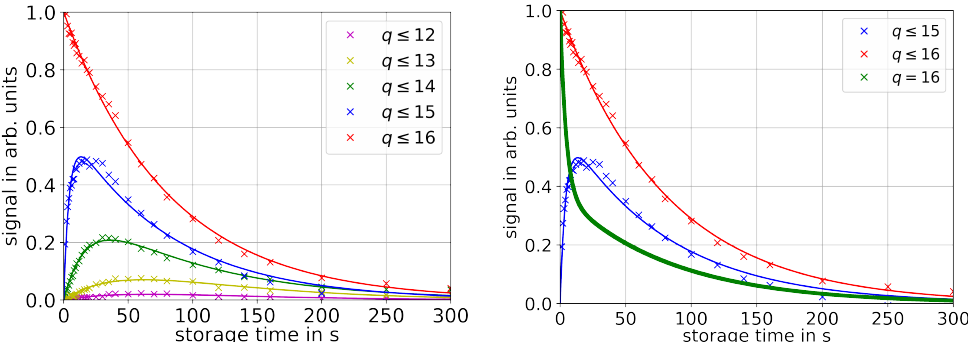
Figure 2. Left : Ion signal for various storage times and charge states. The red plot contains all charge states in the trap, the blue one only the charge states 15+ and lower and so on, as indicated in the legend. Each signal was normalized to the initial signal of the red plot. Right : Additionally to the plots for charge states q ≤ 16 (red) and q ≤ 15 (blue), the deduced population of Ar 16 + -ions is plotted in